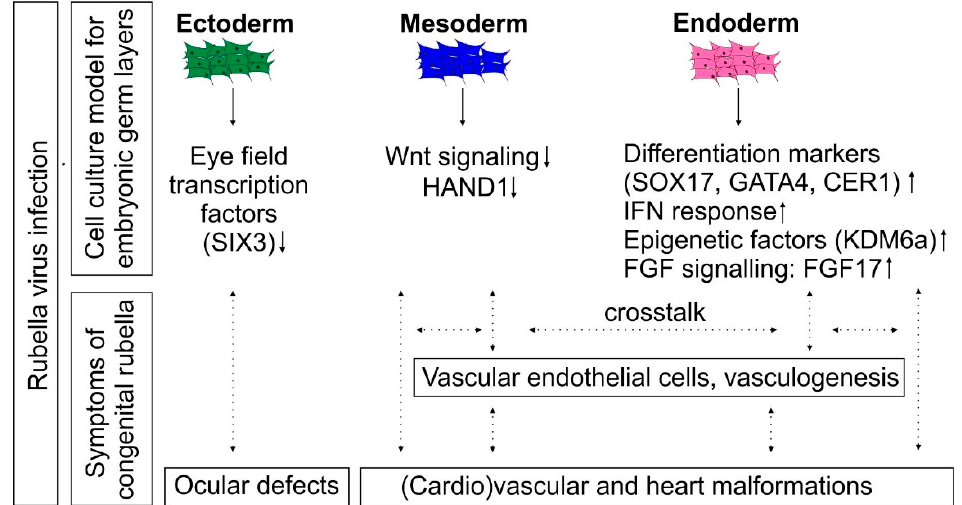
Figure 7. Graphical summary of the identified molecular alterations induced by RV during directed differentiation of iPSCs into the three embryonic germ layer cells. The data was set in a possible relation to the prevailing symptoms of congenital rubella embryopathy. Especially endodermal cells were characterized by profound alterations in their gene expression landscape, including the expression of markers for definitive endoderm and epigenetic factors. This could impair the crosstalk between endodermal and mesodermal cells during differentiation.